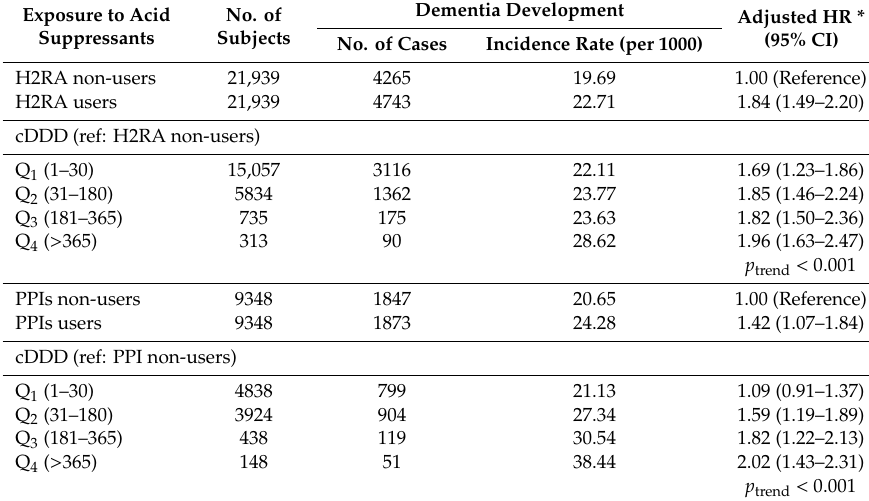
Table 2. Risk of exposure to acid suppressants for dementia development.